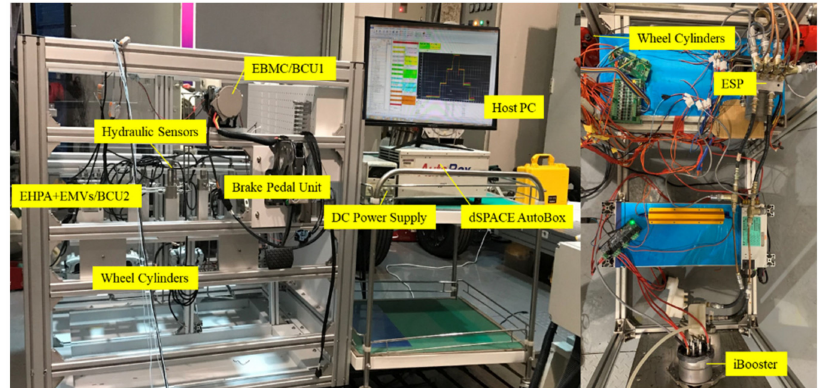
Figure 13. Prototype of manufactured DREHB and HIL test